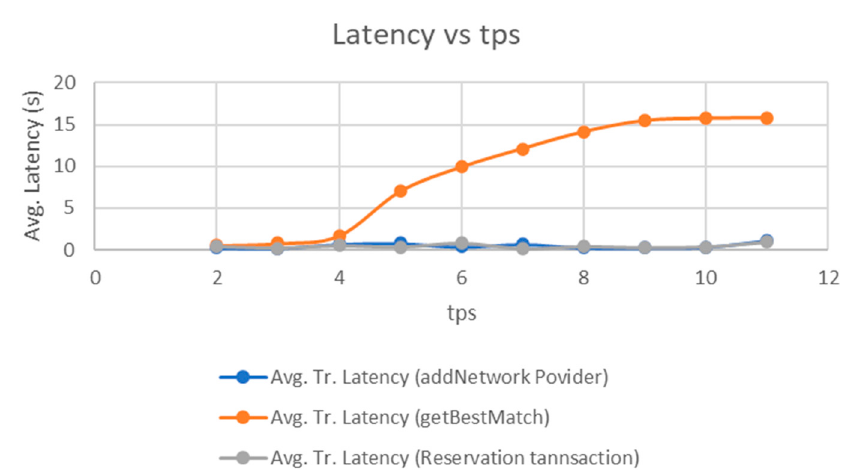
Figure 4. The latency per smart contract function for different transaction loads (submitted transactions per second)